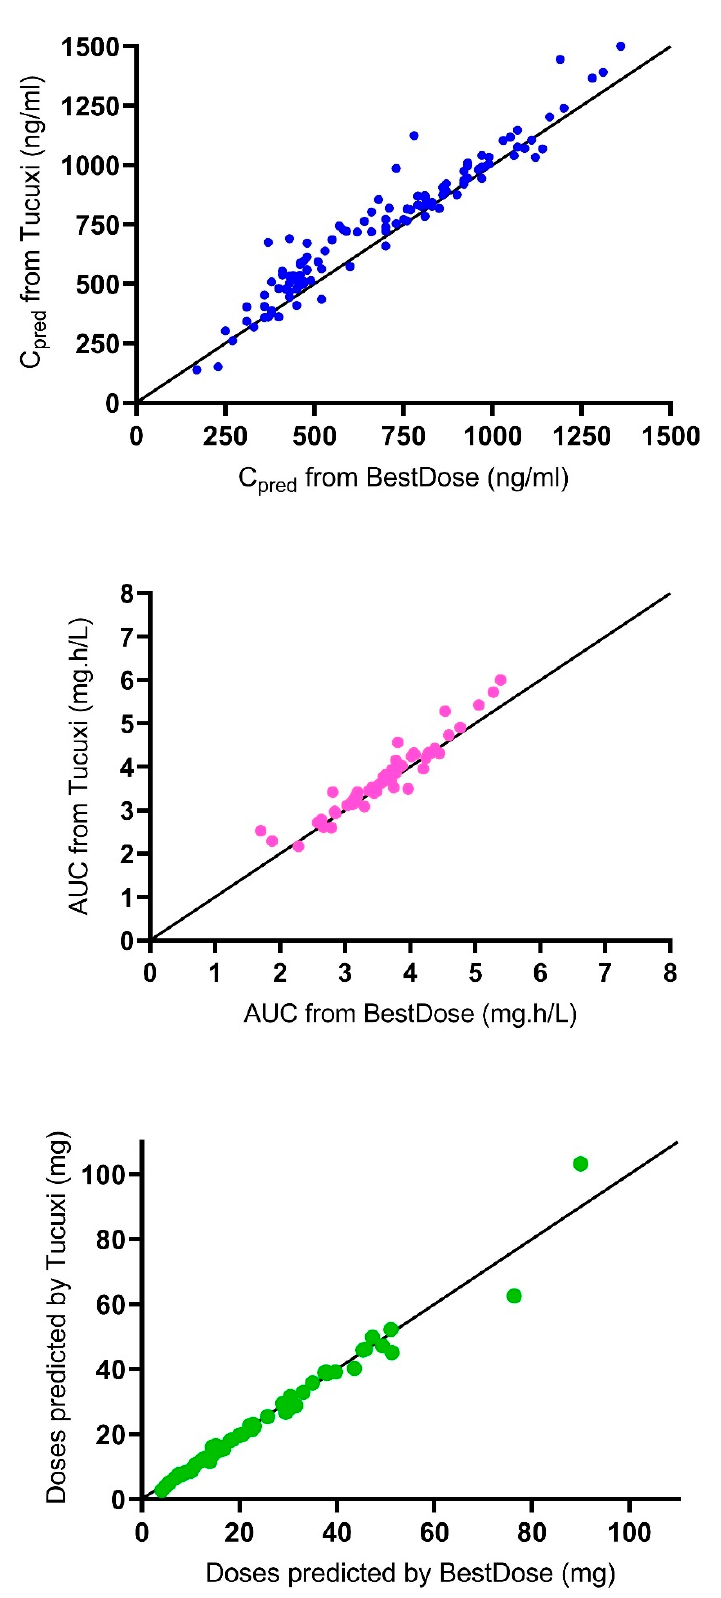
Figure 1. Correlation between results from Tucuxi and BestDose. Upper panel, predicted concentrations (C pred ); medium panel, estimated AUC 0–6 ; bottom panel, predicted doses. The solid line is the line of identity (y = x).